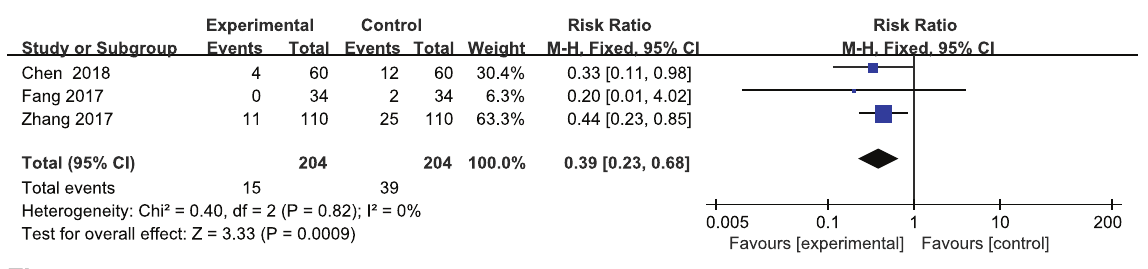
Figure 5. The incidence of vomiting.